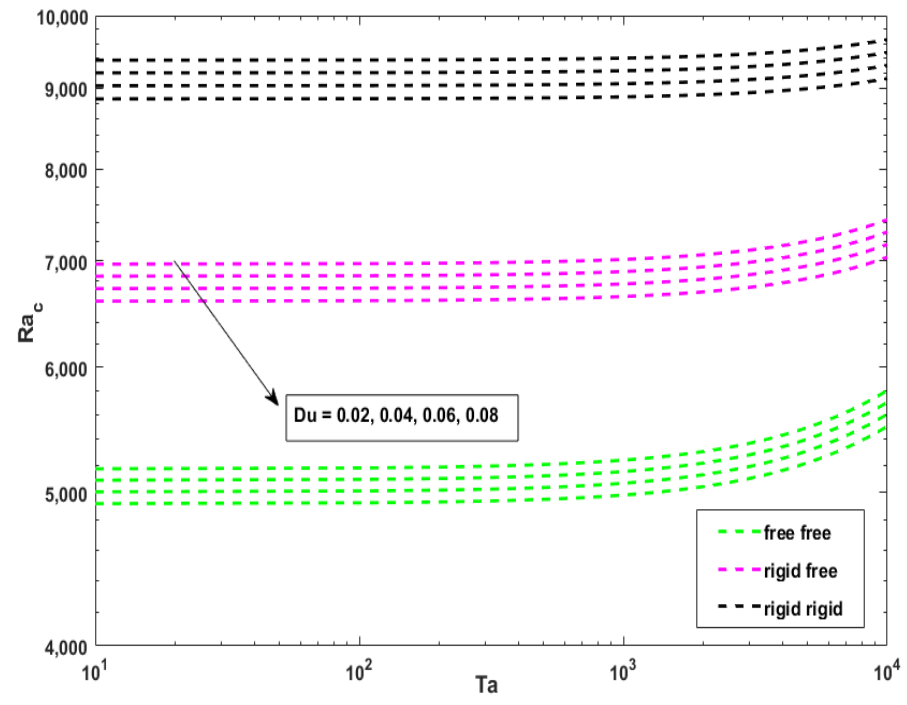
Figure 3. Variation of a c with Ta for Da = 0.01, Du = 0.02, Rs = 200, Le = 5, Λ = 8, M = 0.9, ϕ = 0.9.